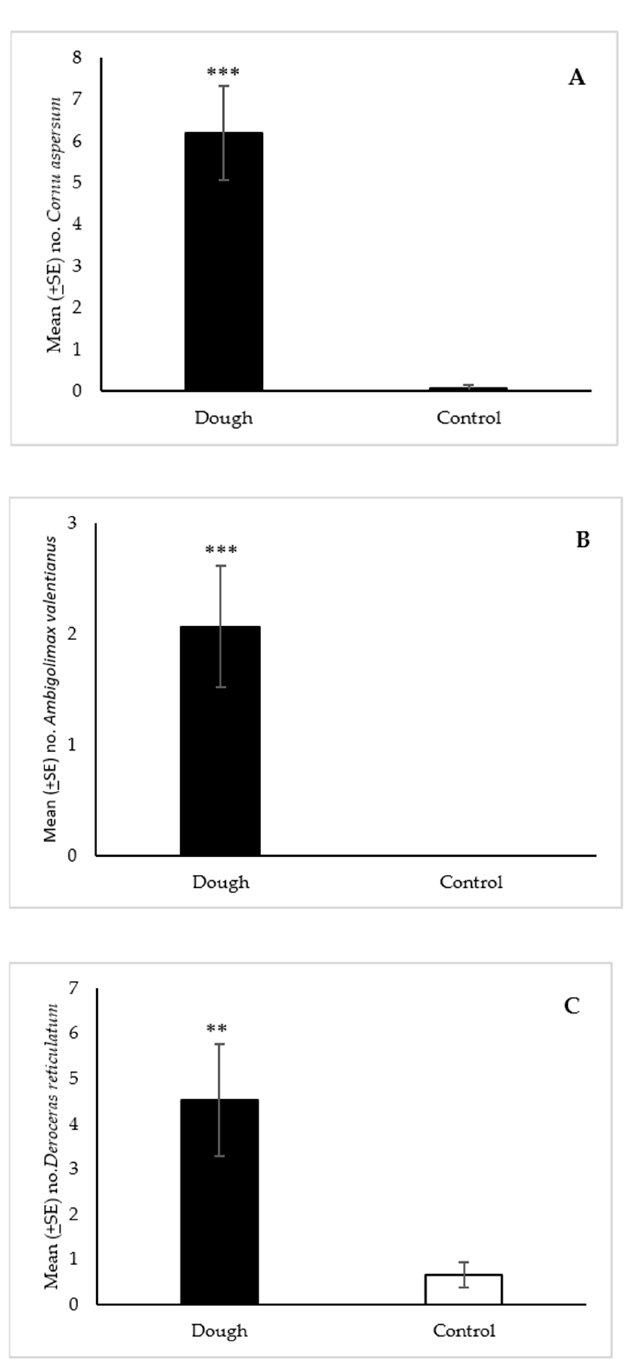
Figure 3. Mean ( ± SE) number of Cornu aspersum ( A ), Ambigolimax valentianus ( B ), and Deroceras reticulatum ( C ) collected per trap over 24 h in Snailer ® traps baited with 2-day aged bread dough or a water control in field trials in Oregon. Traps also contained liquid metaldehyde at labeled rate. Treatment bars with asterisks indicate significant differences (** p < 0.01, *** p < 0.001) between the median number of specimens collected in the dough and control traps. Mann Whitney U test (n = 15): ( A ) standardized test statistic = 4.60, p < 0.001; ( B ) standardized test statistic = 3.70, p < 0.001; ( C ) standardized test statistic = 3.29, p < 0.01.